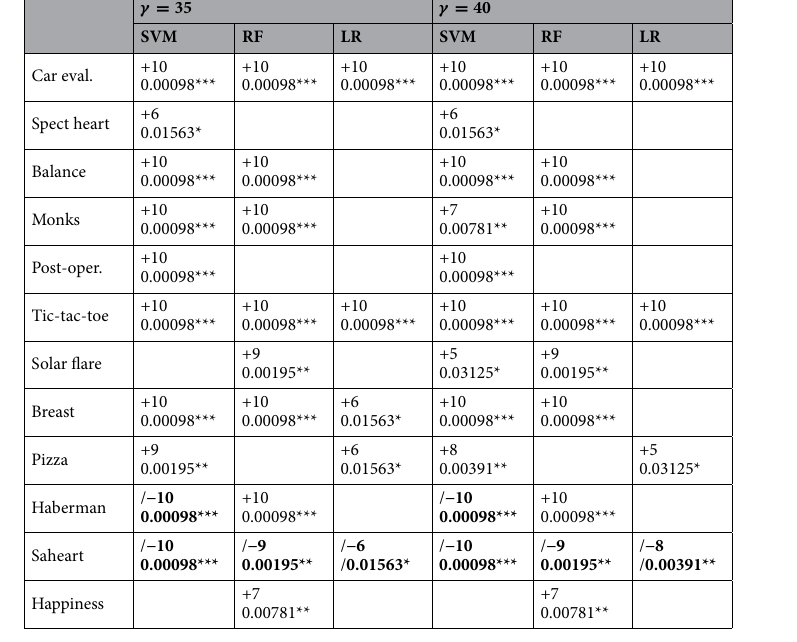
Table 11. Analogous to Table 8 but with γ = 35, 40 .